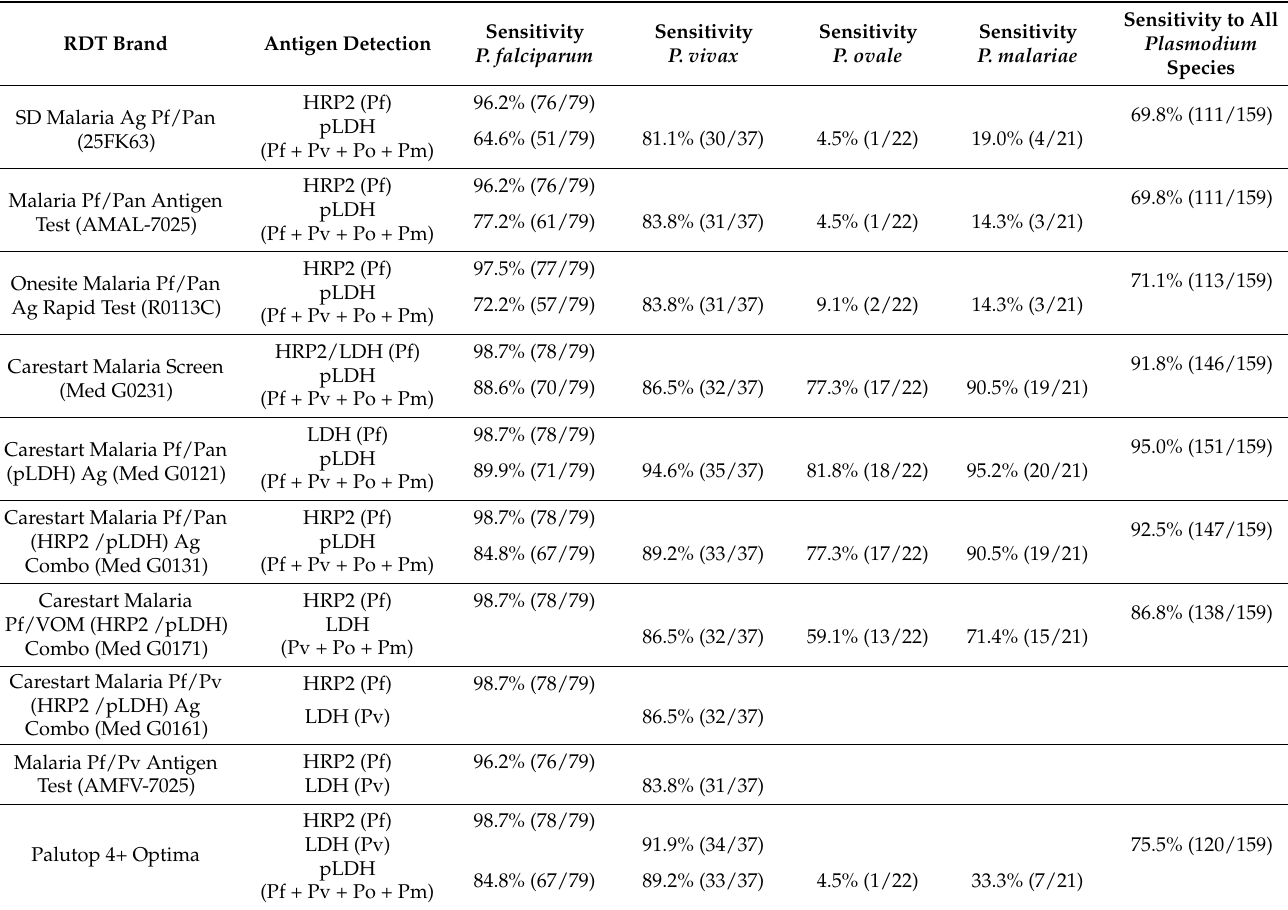
Table 2. Sensitivity of 10 rapid diagnostic test (RDT) kits against 159 samples including 79 P.